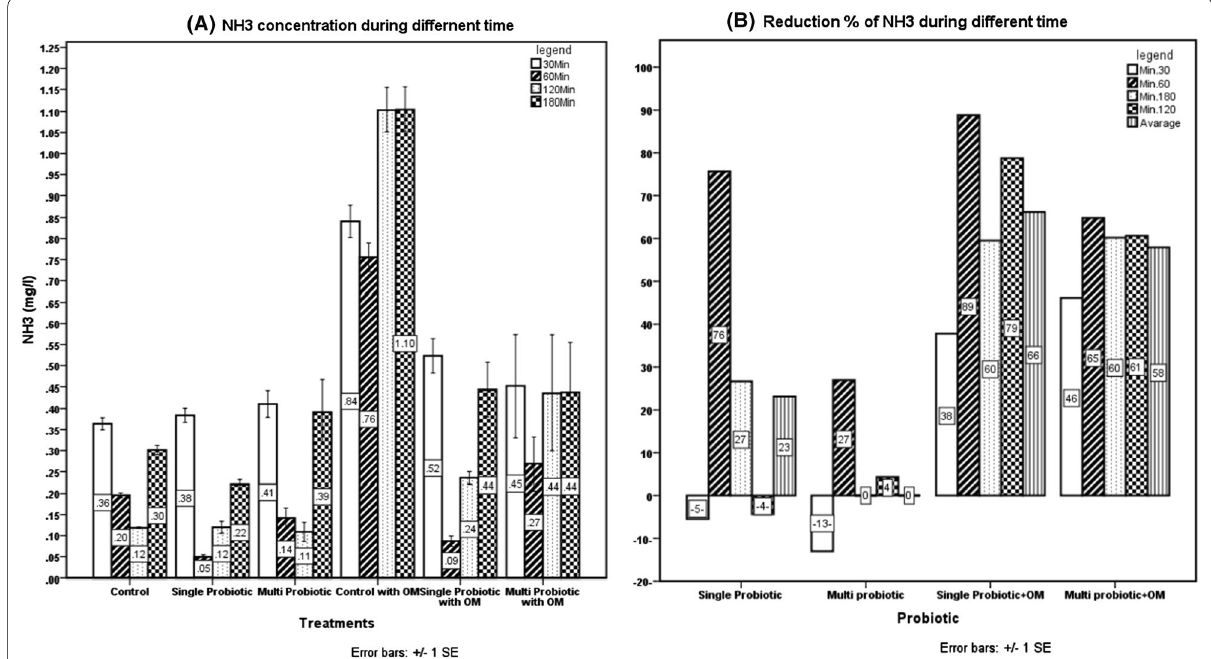
Fig. 1 Effect of probiotics on unionized ammonia (NH 3 ) level in the presence or absence of organic matter. Means are statistically different (P ≤